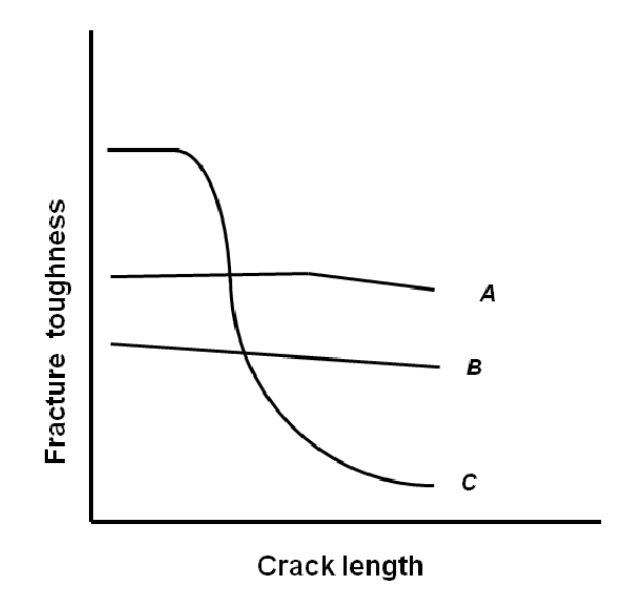
Figure 5. Material classification according to the influence of the crack length on the fracture toughness (adapted from